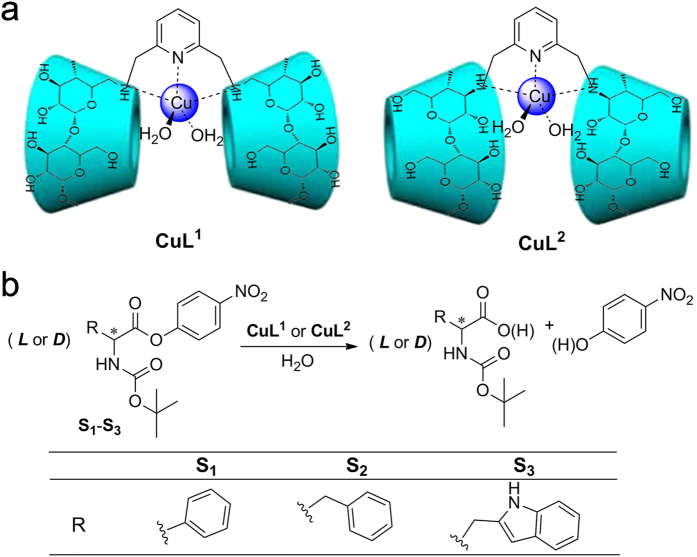
Schematic representations of (a) the structures of CuL1 and CuL2 and (b) the hydrolysis of S1, S2 and S3 catalysed by CuL1 and CuL2.